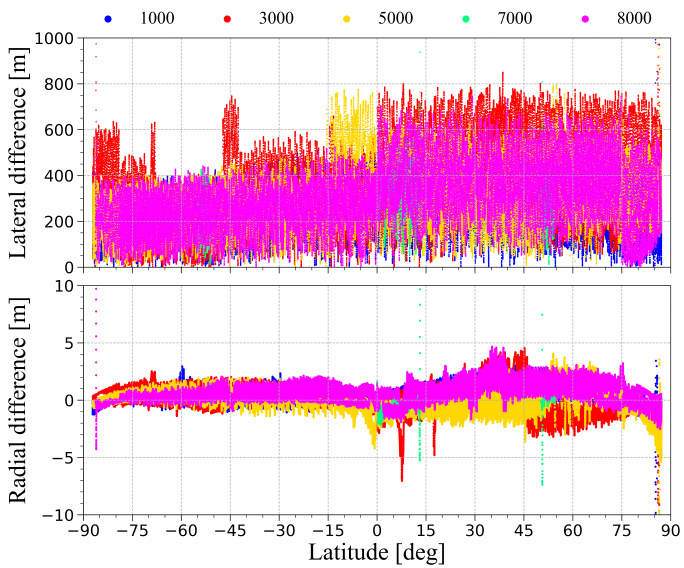
Figure 11. Lateral ( top ) and radial ( bottom ) differences of SMM with Mars as the observer and using the PEDR-documented MGS attitude information, with respect to the locations documented in the PEDR dataset for the selected nadir